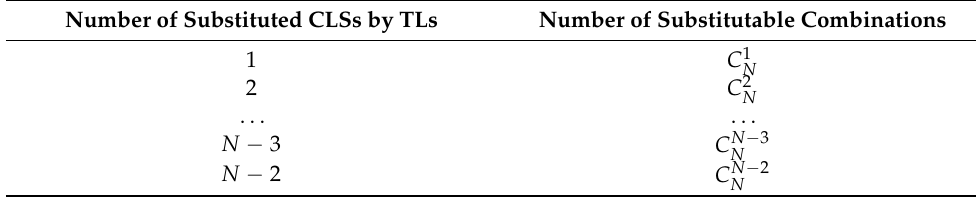
Table 1. The number of substitutable cases for N -section IT. Number of Substituted CLSs by TLs Number of Substitutable Combinations 1 C 1 2 C 2 . . . . . . N − 3